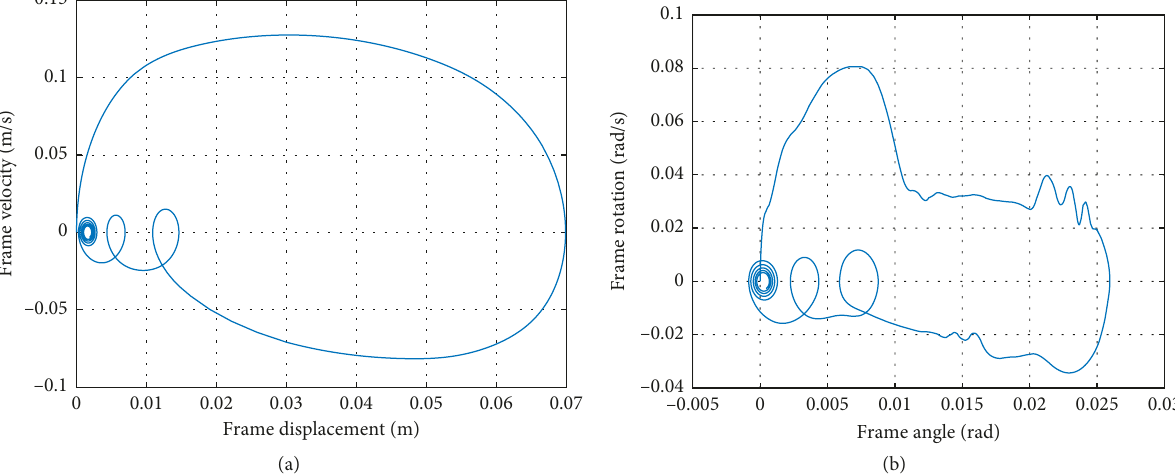
Figure 14: Decreasing load followed by free vibration. (a) The displacement-velocity phase plane and (b) the angle-rotation phase plane.